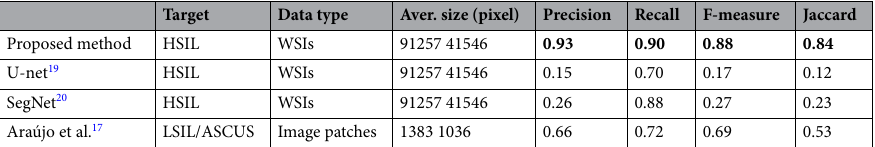
Table 2. Quantitative comparison with benchmark methods. The proposed method is significantly better than the benchmark approaches